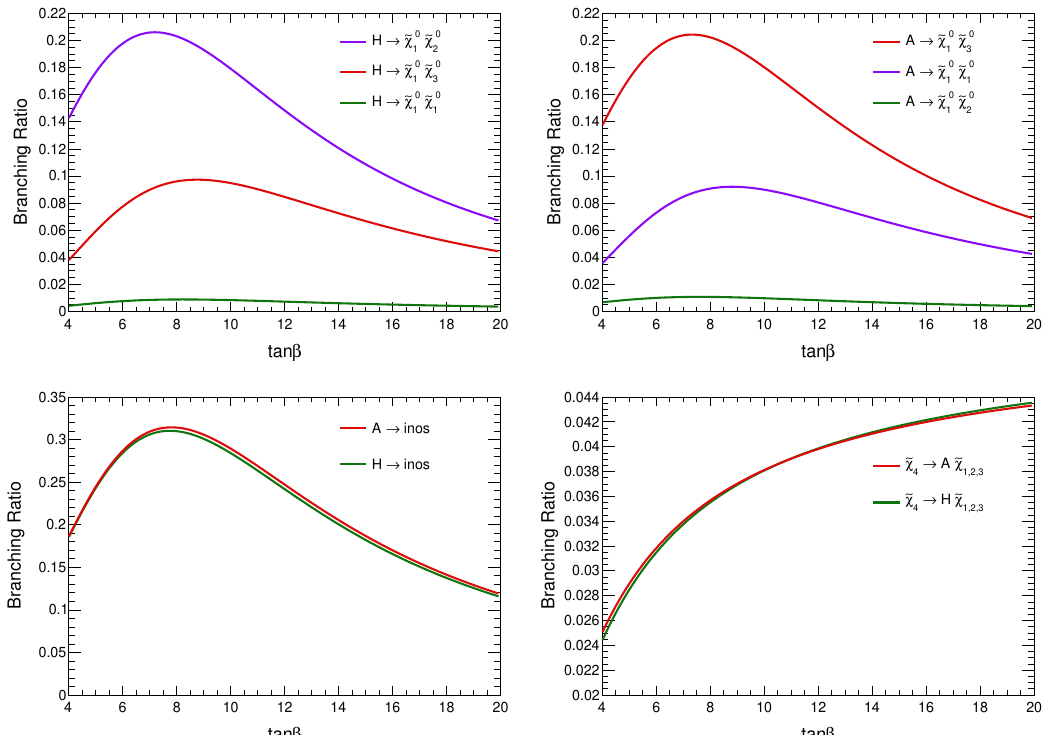
Figure 3. Dominant branching ratios for heavy CP-even and CP-odd Higgs decays to individual electroweakino modes (top panel), the total branching ratio for two heavy Higgs (bottom left), branching ratio of heaviest neutralino decays to heavy Higgs (bottom right) for the case-1c. The wino, bino, higgsino mass parameters M 2 , M 1 , µ are fixed at 1500, 100 and 450 GeV and tan β is